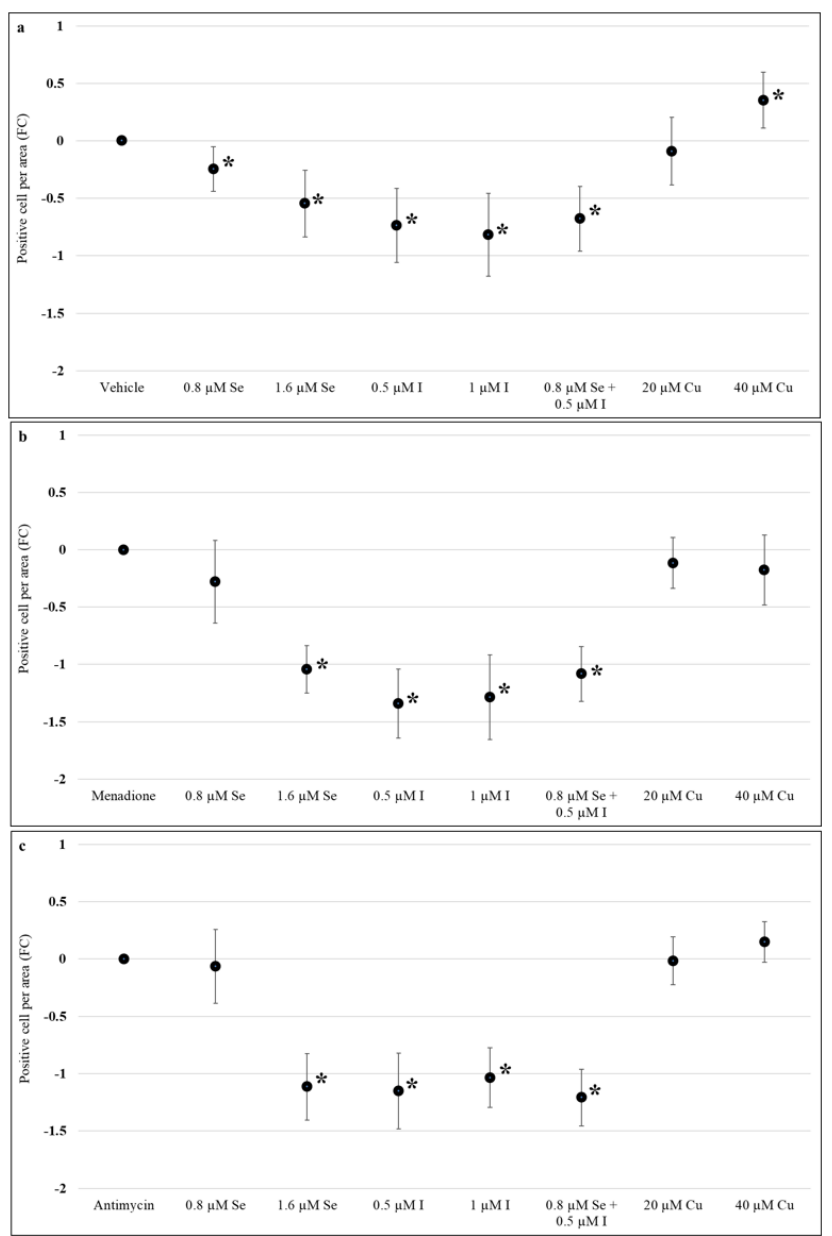
Figure 4. Effect of selenium, iodine, and copper supplementation on apoptosis in first trimester placental explants. Pla- centa explants from 7 to 12 weeks of gestation ( n = 12) were cultured for 48 hours for syncytial regeneration followed by supplementation with sodium selenite (0, 0.8, or 1.6 µM), potassium iodide (0, 0.5, or 1 µM), combination of sodium sele- nite and potassium iodide (0.8 µM sodium selenite and 0.5 µM potassium iodide), or copper (II) sulfate (0, 20, or 40 µM) for 72 hours with supplementation replenished every 24 hours. ( a ) Placental explants were harvested at the end of 72 hours supplementation and apoptosis assessed by immunolabelling for cleaved caspase-3. In addition, after 72 hours supple- mentation, placental explants were treated with ( b ) 120 µM menadione or ( c ) 480 µM antimycin for 24 hours to induce oxidative stress and then assessed for apoptosis. Eight randomly selected regions per explant were used for quantification